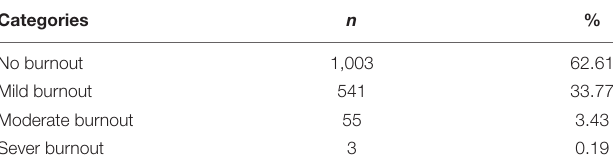
TABLE 2 | Prevalence of burnout at different levels among medical staff. TABLE 3 | Prevalence of three dimensions of burnout at different levels among medical staff.